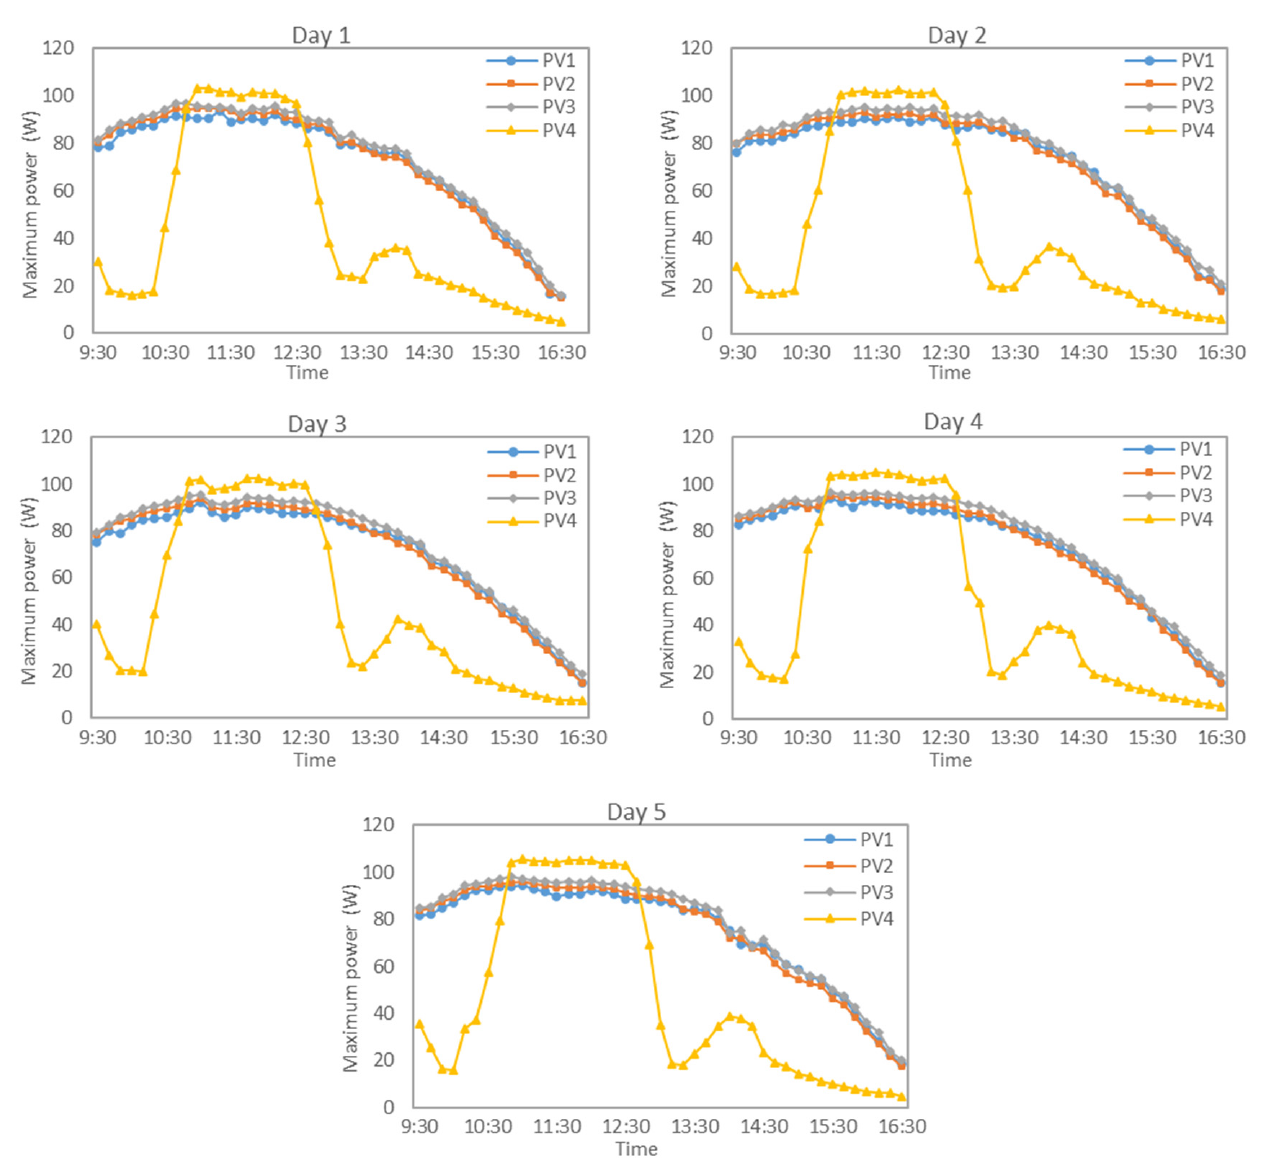
Figure 7. The maximum electrical power recorded by the PV analyzer over five days in October for the four PV panels .